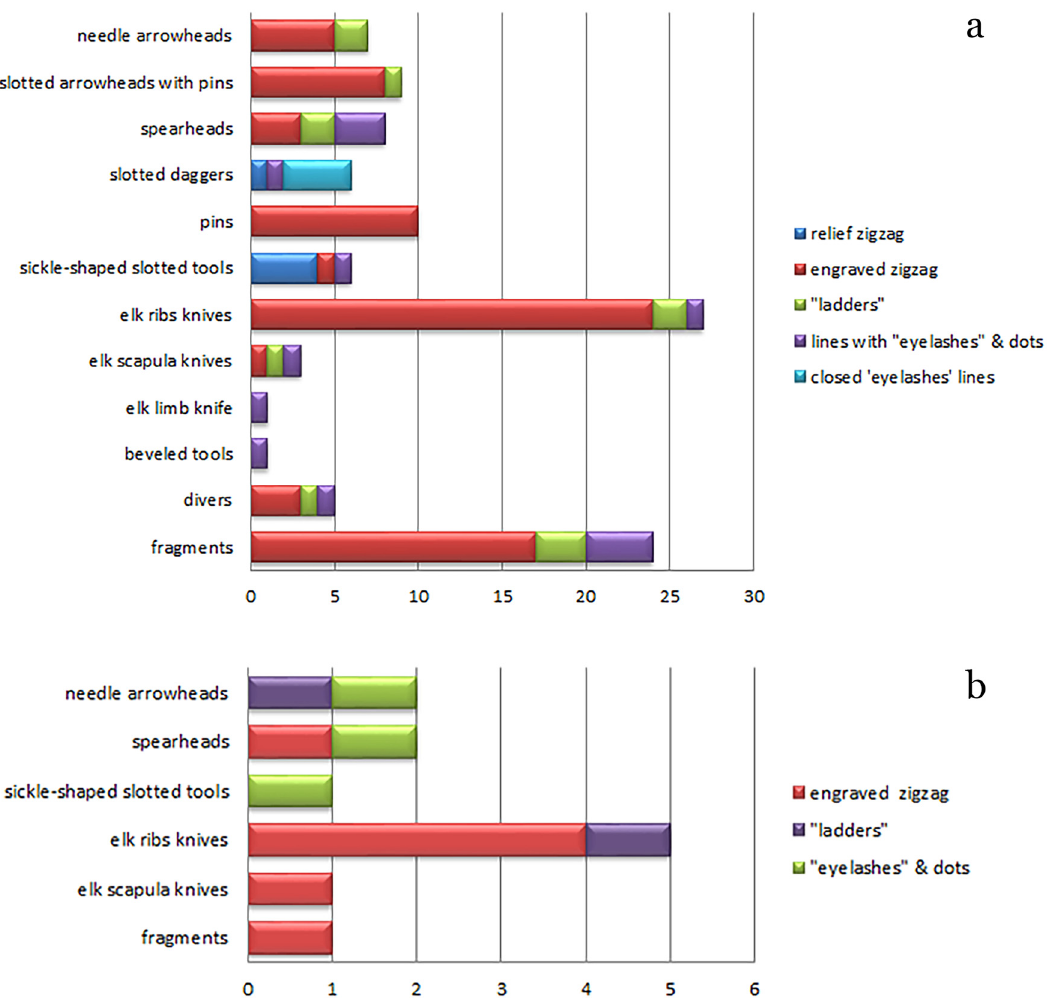
Figure 6: Zamostje 2. Correlation of ornamental motifs with types of bone ( antler ) tools. a – Mesolithic artefacts and without exact chronological context ( probably Mesolithic ) ; b – Early Neolithic